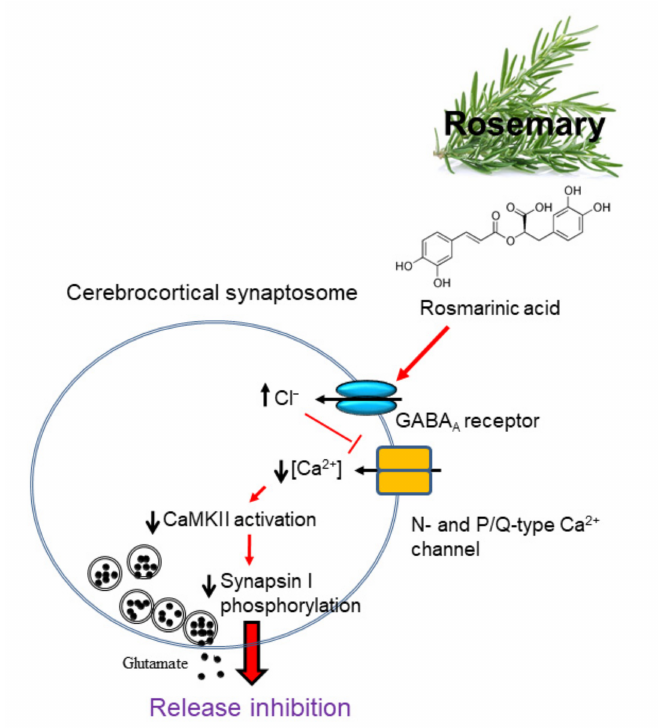
Figure 7. A proposed mechanism underlying the inhibition of glutamate release by rosmarinic acid in rat cerebrocortical